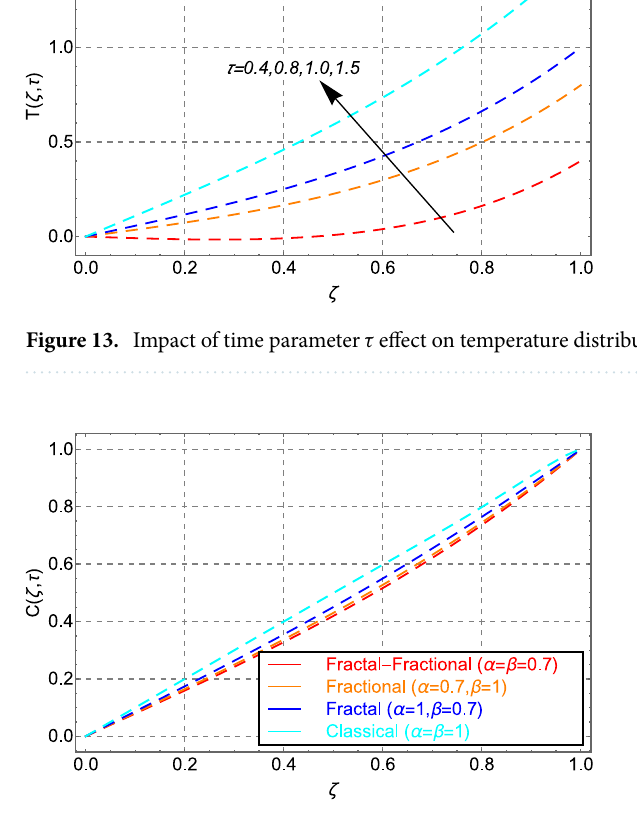
Figure 14. Comparison of Concentration distribution for fractal-fractional, fractal, fractional and classical order.